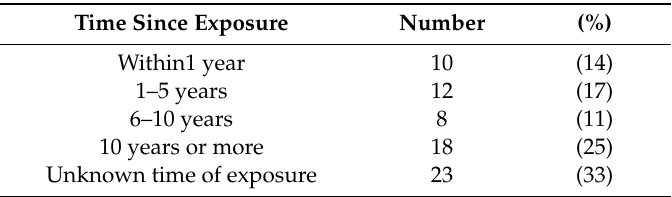
Table 3. Timing of exposure to the source case among the TB patients who had a history of contact, in Udupi district, Karnataka, India during October 2018–June 2019 ( n = 71). Time Since Exposure Number (%) Within1 year 10 (14) 1–5 years 6–10 years (25) Unknown time of exposure 23 (33)